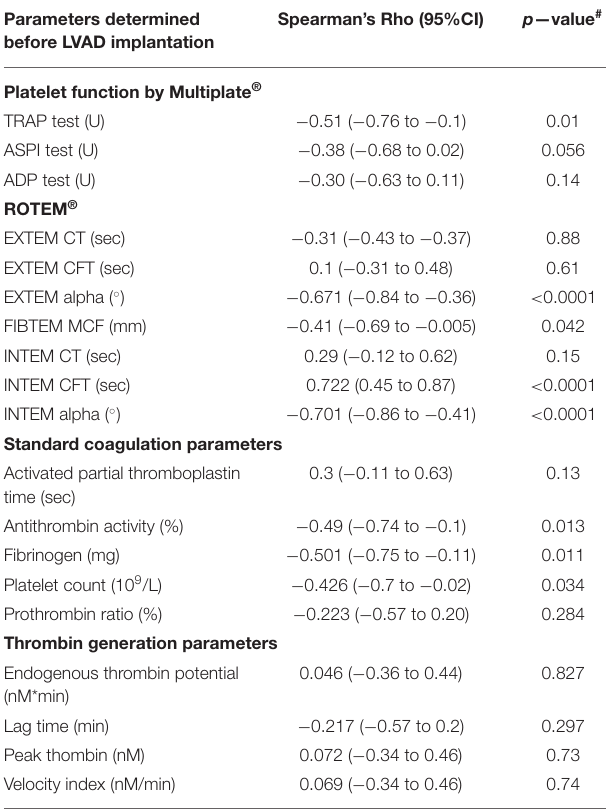
TABLE 4 | Spearman’s correlation analysis for the relationship of preoperatively determined coagulation ( = before LVAD implantation) parameters with the estimated total blood loss (ml) during observation